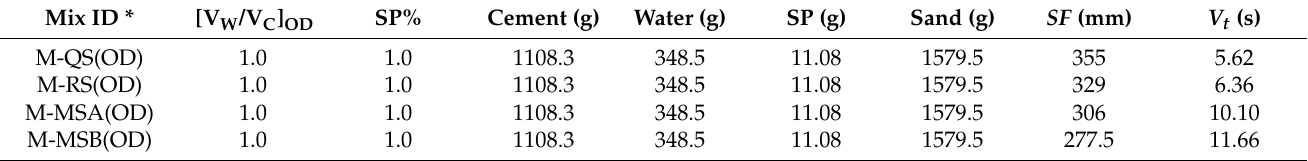
Table 1. Mix proportions and experimental results of mortars for sands in OD conditions.